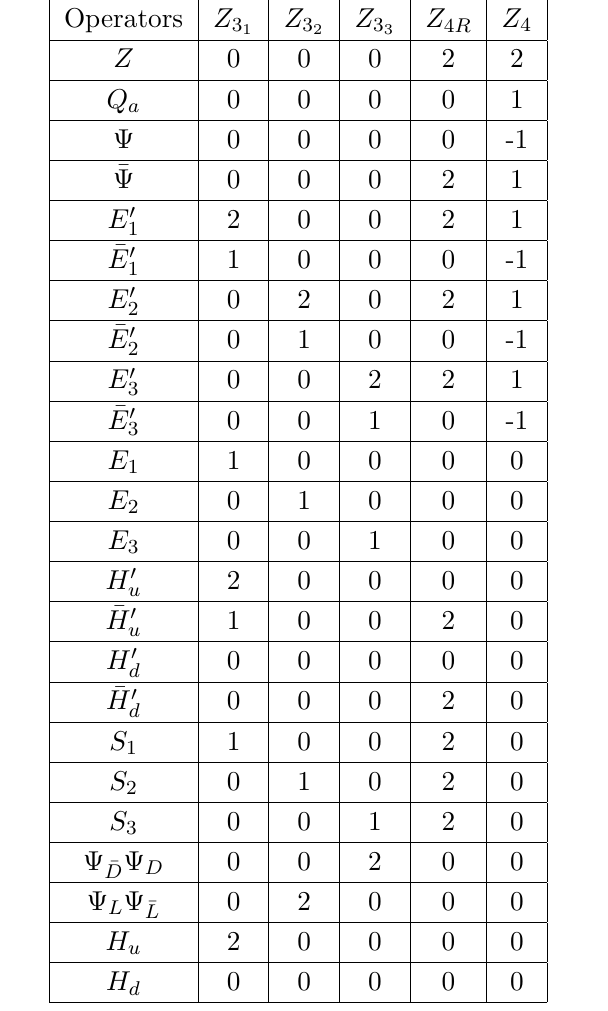
Table 2 . Charge assignment for all the